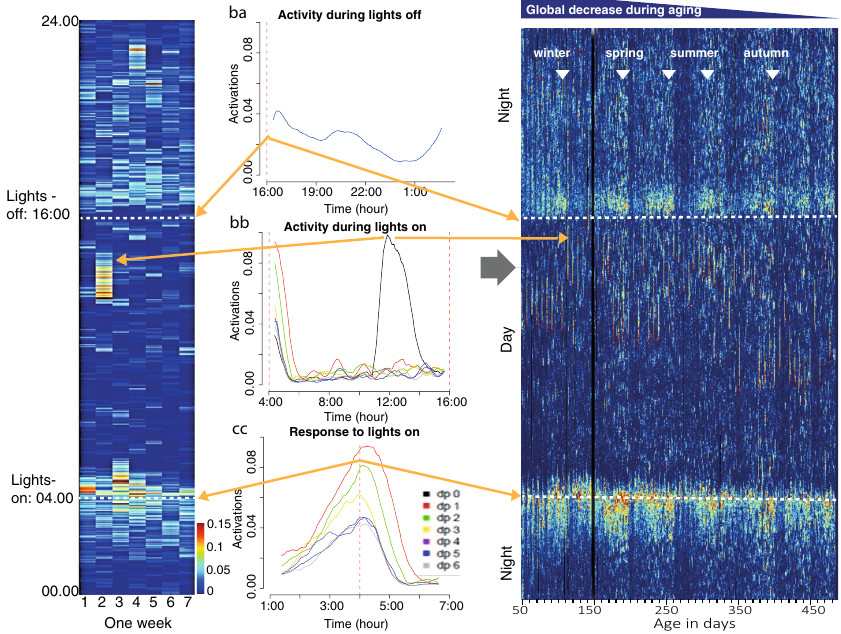
Figure 1. ( a ) is a heat map with seven columns corresponding to the days of one calendar week (day 1 to 7) with color coded activations (for conversion see scale to the right) illustrating the daily rhythmicity in activity synchronized to lights-on (4 AM, white stippled line in a , c ) and lights-off (4 PM, white stippled line in a and c) in one cage (A04) with 5 male mice. ( b ) Details of the response to lights-on is shown for each weekday in bc (separate color coded trace for each week day, with dp0 being the day of the cage); followed in bb by the day-time resting pattern (middle graph; each day is color coded as in bc ). The cage is changed once a week (day 2 in ( a ) and dp0 in graph) which instigates a dramatic increase in activity with a carry-over impact on the next following days (see bc ). ( ba ) shows the response to lights off and night time activity and is the average across weeks. In ( c ) the whole data-set of activations across the 434 days (see Table 1) is shown for the same cage (A04). The ordinate is the same as in ( a ) while the abscissa is animal age in days (49 to 483 days of age). The elements of the circadian rhythm across day and night in ( a ) is also evident in ( c ) (orange arrows to aid navigation). There is an over-all decrease in activity, albeit small yet statistically highly significant (− 4% for this cage; P = 2E−10; see Supportive information Table S1). Inspections of the long term records of activations ( c ) revealed a marked slow oscillation of peaks (highs; indicated by filled inverted triangles) with intervening